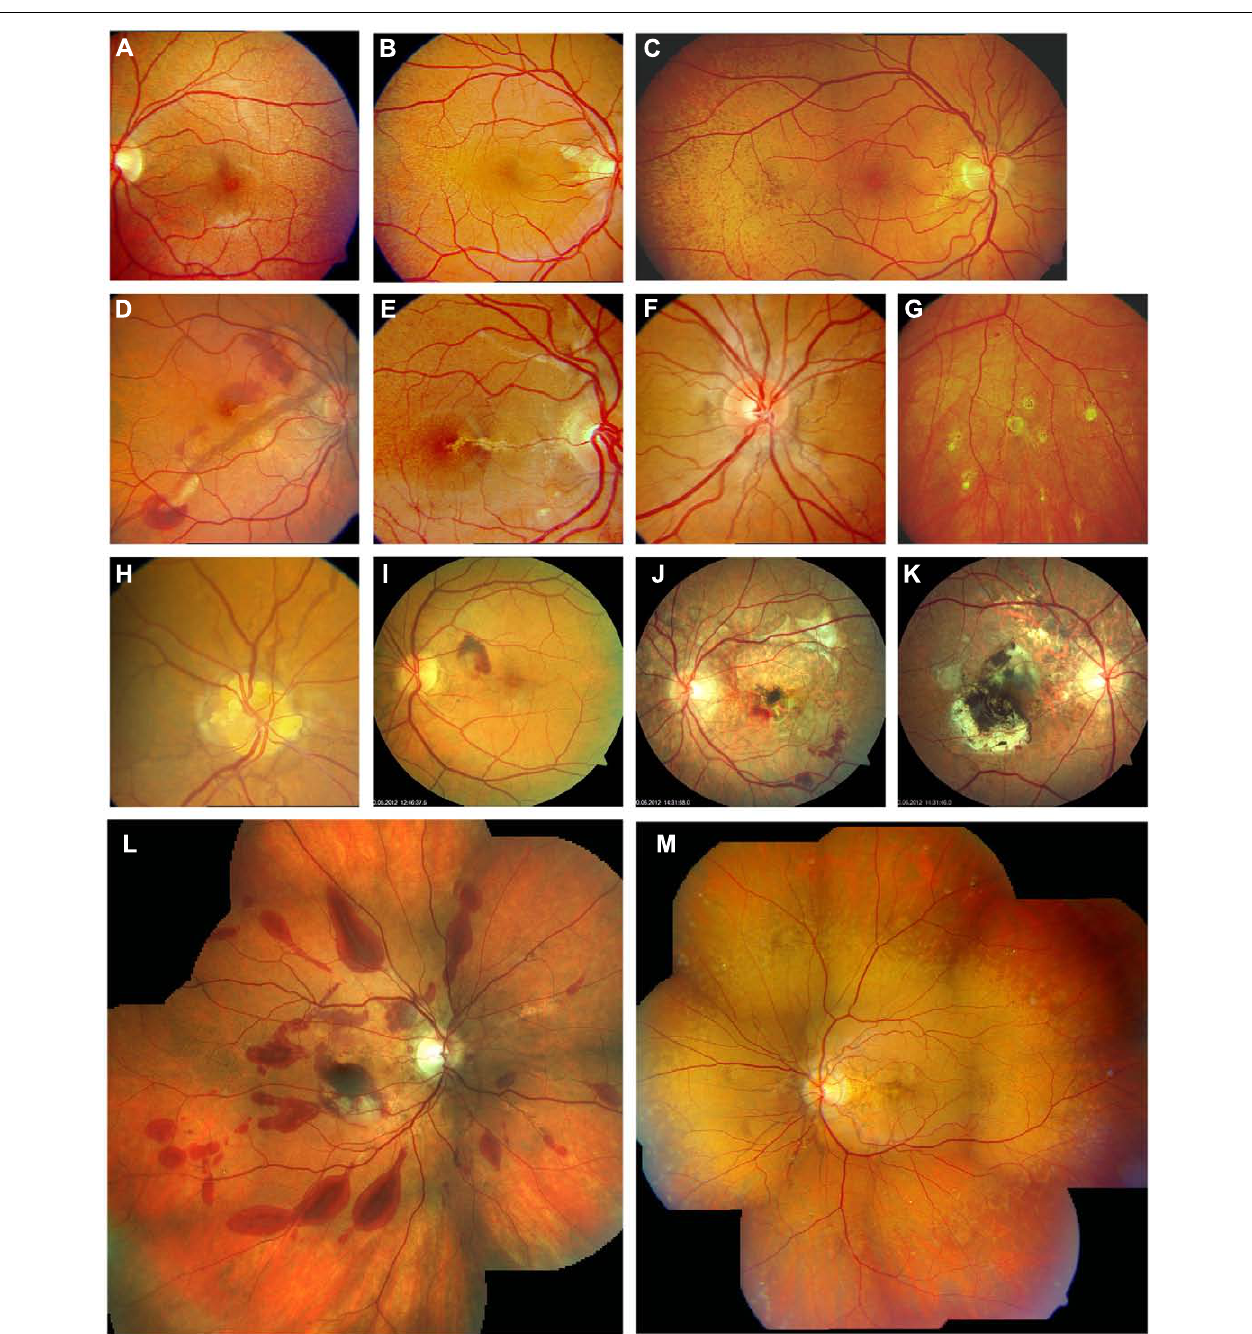
FIGURE 1 | Clinical features of pseudoxanthoma elasticum on funduscopic examination. Peau d’orange is characterized by small dark spots on a whitish or opaque background (A–C) and likely represents the transition between calcified and non-calcified Bruch’s membrane. Peau d’orange appears to begin at the posterior pole (A) , spreading peripherally over time (B,C,M) . Peau d’orange is most pronounced temporaly but may be visible circular within the retinal periphery (M) . Angioid streaks are reddish or brownish irregular lines that often form a peripapillary ring from where they radiate into the periphery (D–F,H,M) . Small roundish chorioretinal atrophies are frequently found in the retinal periphery eccentric to peau d’orange, but may also occur closer to the optic nerve head.They often